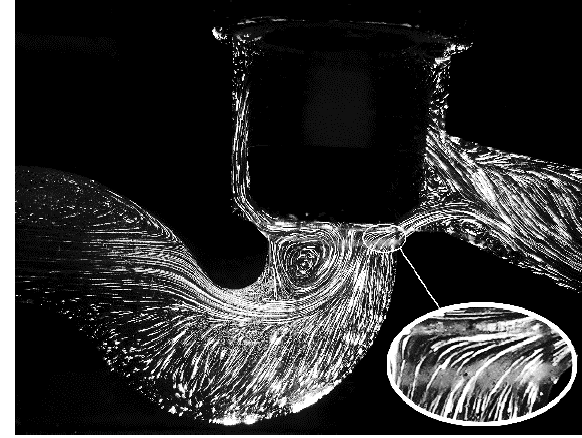
Fig. 7. Visualization in the axial plane of the model. Working fluid was the mixture of water and glycerine (Ri 1.41).